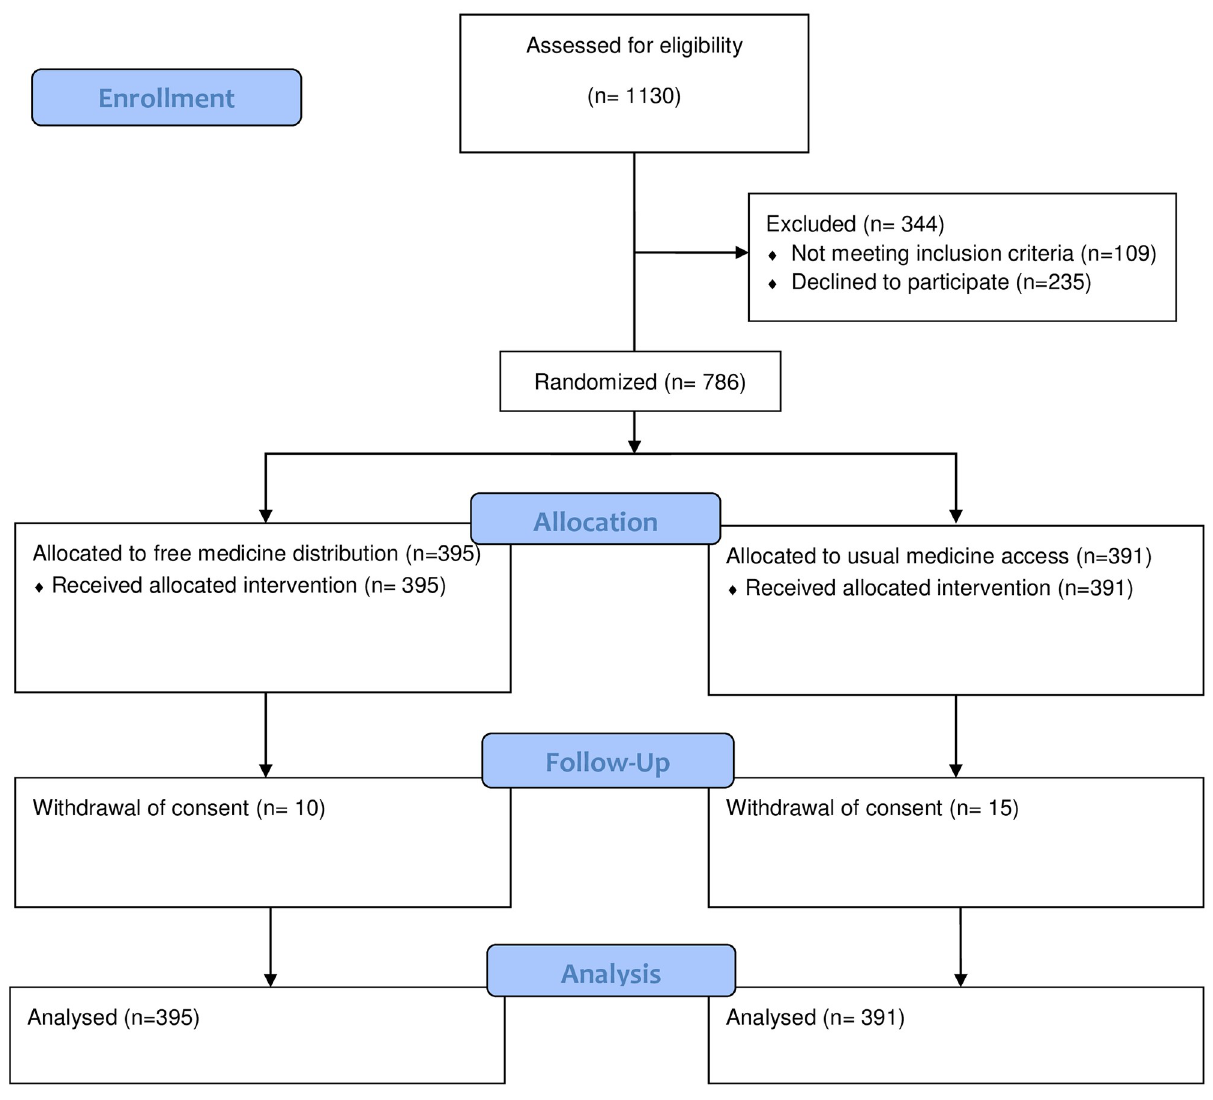
Fig 1. Participant flow